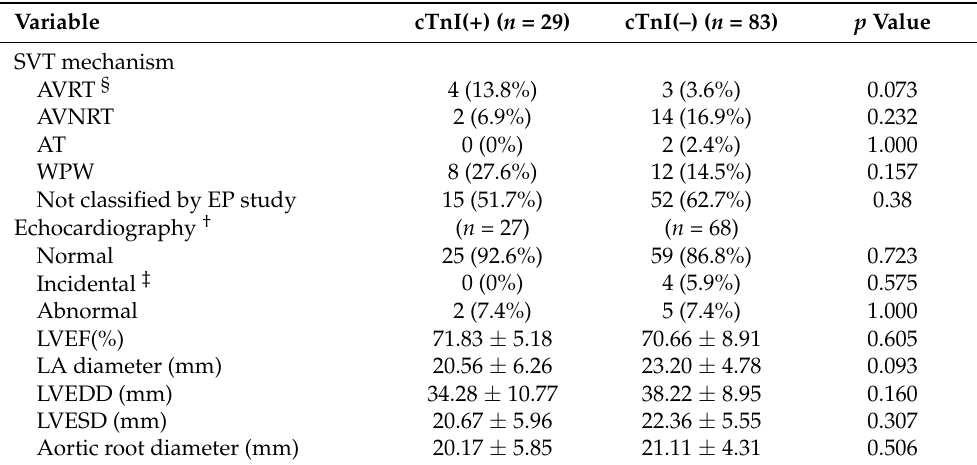
Table 3. Comparisons of SVT mechanisms and echocardiographic findings in patients with or without elevated cTnI levels.